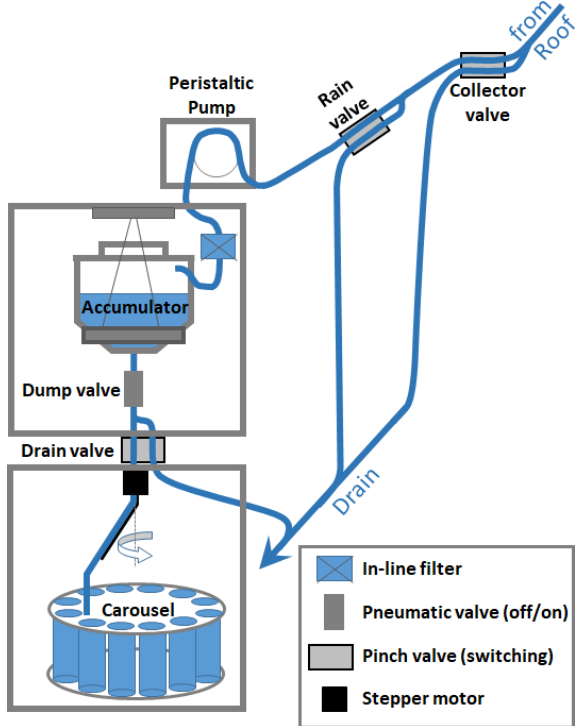
Figure 2. Schematic of the physical components of the current cloud water collection system inside the research observatory at the summit of WFM. A series of valves control where the collected cloud water is directed at specific times, with multiple opportuni- ties to be directed to a waste stream marked “Drain”. Up to 1L is collected in each bottle within the carousel. The two refrigerated parts of the system house the Accumulator and the Carousel, where the sample is stored for up to 3d before delivery to an analytical laboratory for